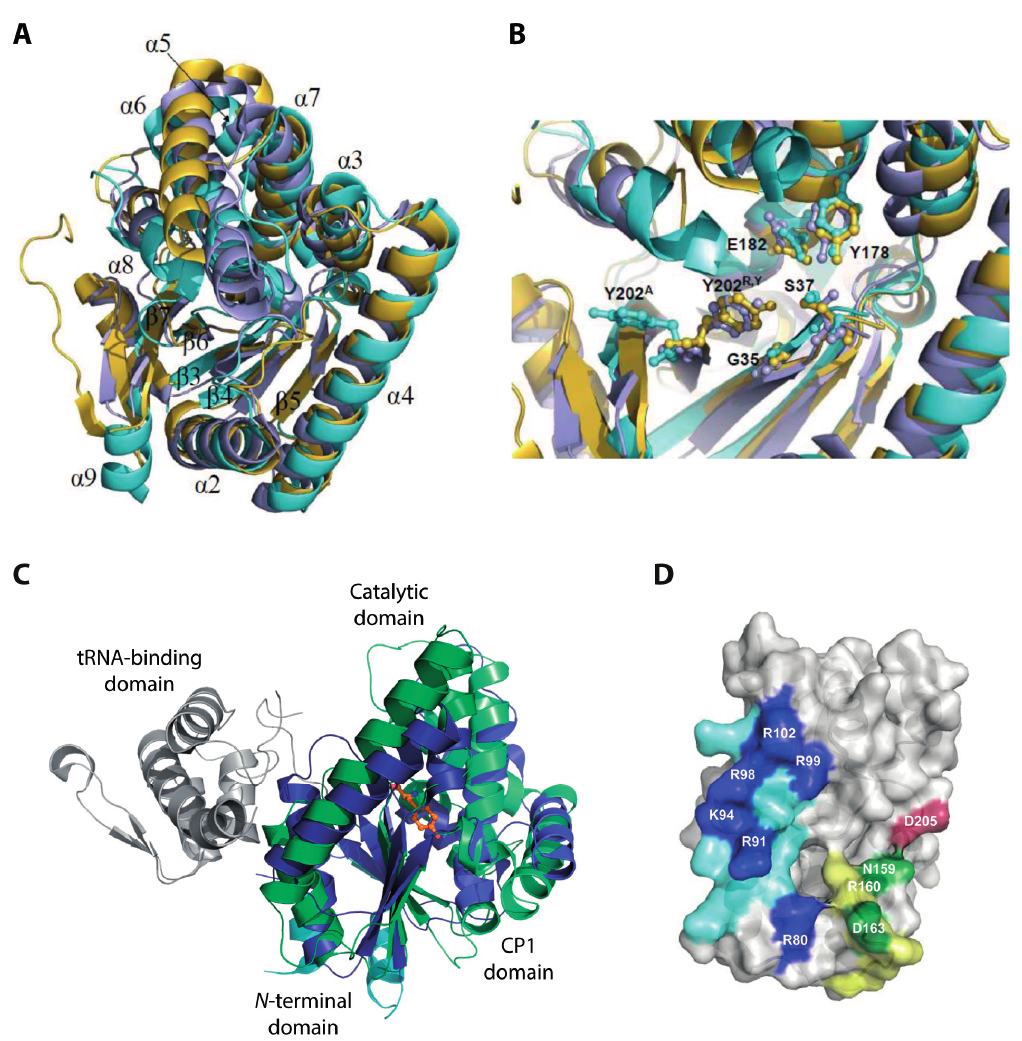
Figure 5. ( A ) Superposition of the AlbC (cyan, PDB (Protein Data Bank) ID: 3OQV), Rv2275 (yellow, PDB ID: 2X9Q) and YvmC-Blic (purple, PDB ID: 3OQH) structures. The numbering of β -strands and α -helices corresponds to AlbC; ( B ) Superposition of the conserved residues inside the active site pocket. The residues are shown in ball and stick style. AlbC numbering is used; ( C ) Comparison of the structures of AlbC and TyrRS Tyr from M. jannaschii in complex with L -Tyr (PDB ID: 1JLU). The enzymes are shown in cartoon style, L -Tyr is shown in ball and stick style in orange. The Rossmann-fold and CP1 domain of TyrRS Tyr are colored in dark and light blue, respectively. The corresponding domains of AlbC are shown in dark and light green. The tRNA-binding domain is colored grey; and ( D ) Regions in AlbC involved in the interaction with tRNA substrates (PDB ID: 3OQV). Basic residues located in helix α 4 are colored in blue. Residues shown in dark blue have been shown to strongly influence the interaction with the first aminoacyl-tRNA substrate. Loop α 6- α 7 is colored in yellow and D205 in loop β 6- α 8 in red. Green and red residues have been shown to influence binding of the second tRNA substrate. ( A , B ) Adapted from [31] with permission of The Royal Society of Chemistry, copyright 2012; ( C ) Adapted from [44] with permission from Oxford University Press, copyright 2011; and ( D ) Adapted from [52] with permission from Oxford University Press, copyright